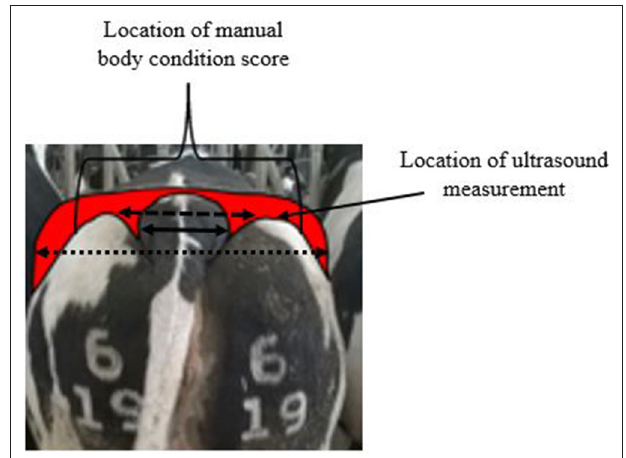
FIGURE 1 | Example of a digital image taken of the caudal area of the cow showing annotation for measurement of tail head width (solid line), distance between hook bones (dotted line), and pin bones (dashed line), and location of manual observed body condition and ultrasound measurement.